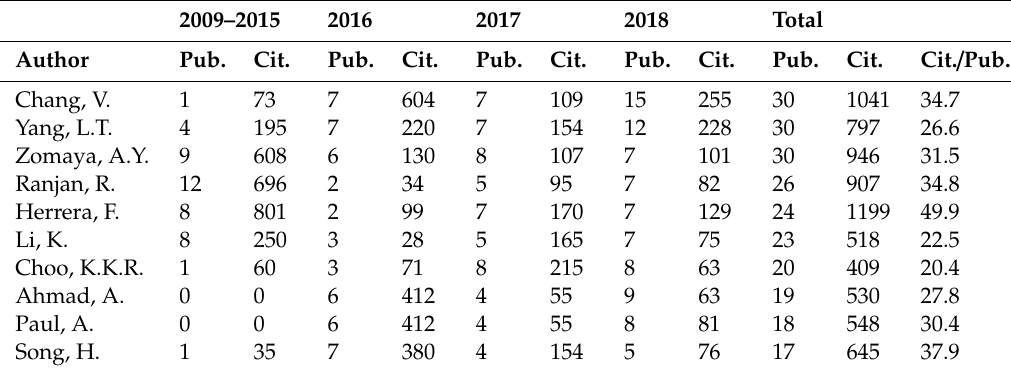
Figure 7. Top 10 most productive authors. Table 4. The number of publications (Pub.) and citations (Cit.) of the top 10 most productive authors in four periods.